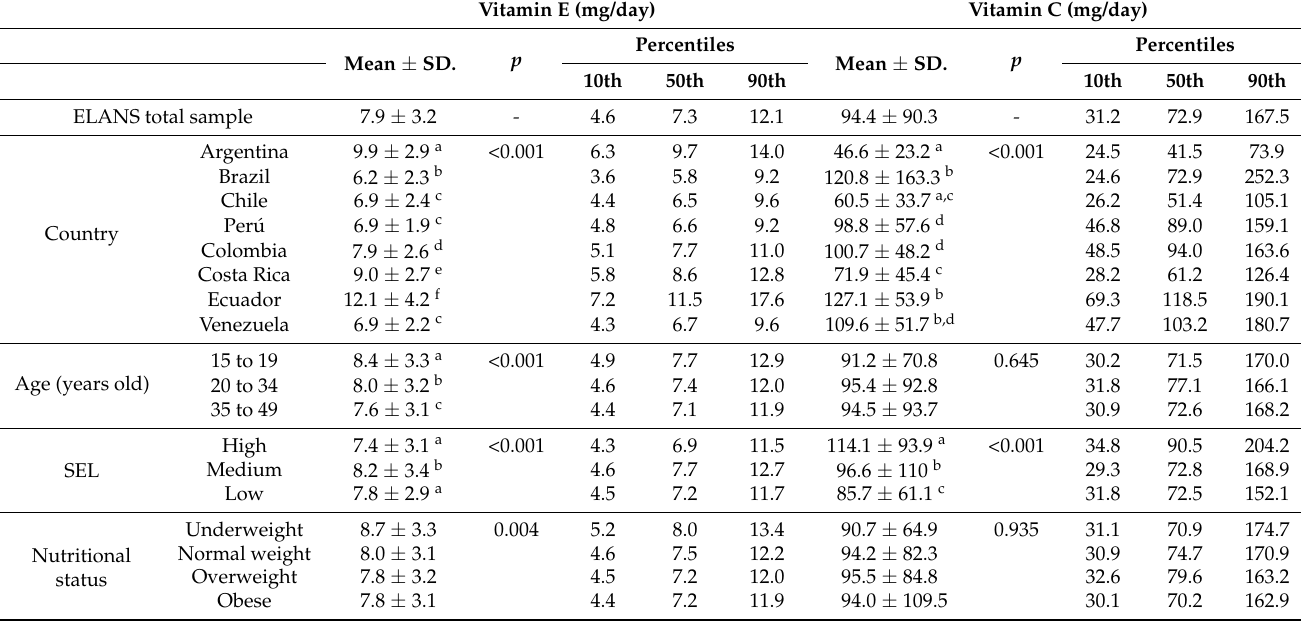
Table 2. Vitamin E and C daily intake in WRA participants of ELANS in different countries and groups.